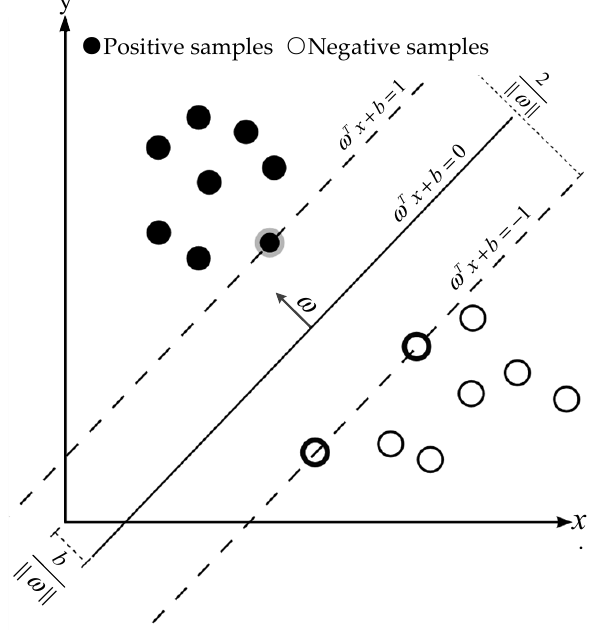
Figure 3. Basic principle of SVM classification.